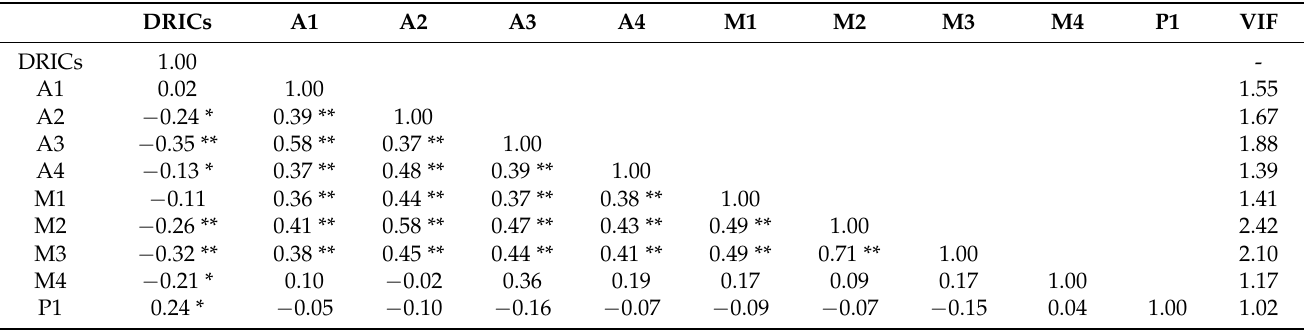
Table 3. Correlation analysis of the regression variables.